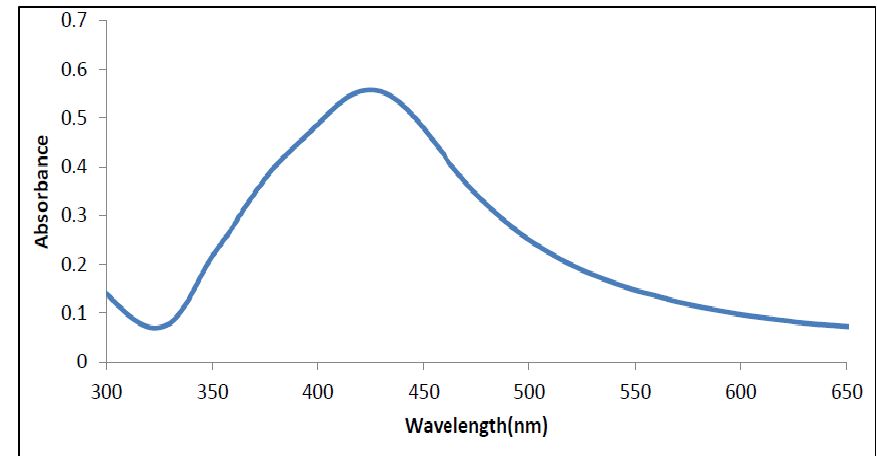
Figure 5: Absorbance spectrum of prepared Ag NPs by chemical reduction method (5 min.) as a reduction period